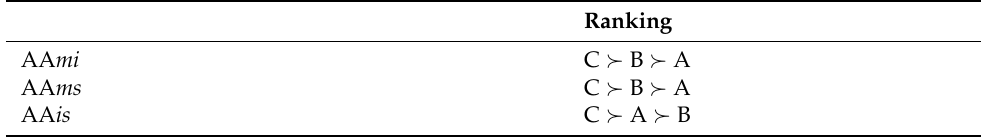
Table 7. Sensitivity measurement effect to the final